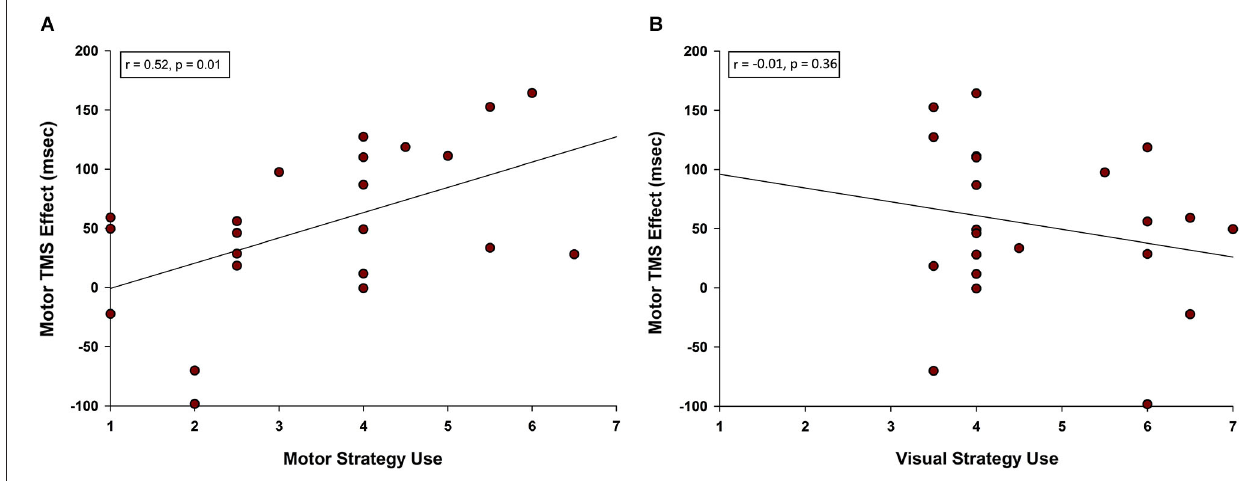
when rehearsing pseudowords and Chinese characters were more disrupted by M1 stimulation. (B) There was no correlation between self-reported use of visual rehearsal strategy and the motor TMS